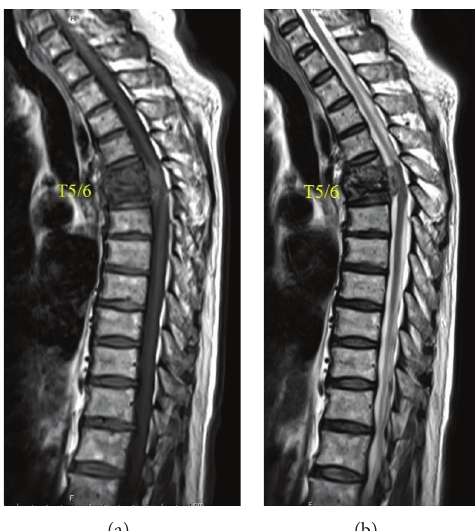
Figure 2: (a) Sagittal T1-weighted and (b) sagittal T2-weighted magnetic resonance imaging of the thoracic spine shows destruction of the T5 and T6 vertebrae and an epidural soft tissue mass with anterior dural sac